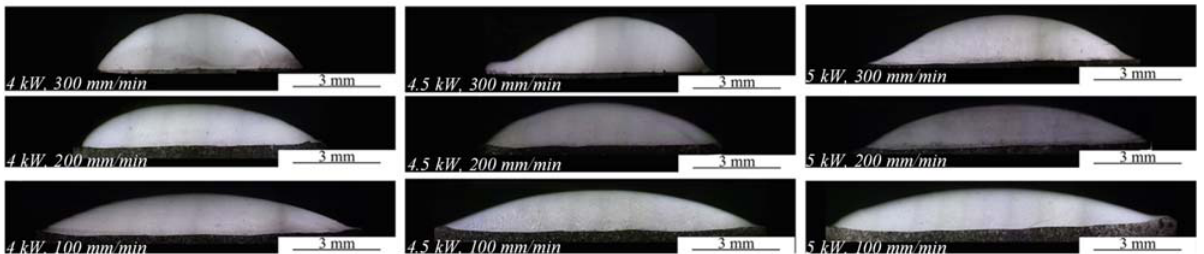
Figure 2. Cross ‐ sectional morphology of Ni35 coatings.